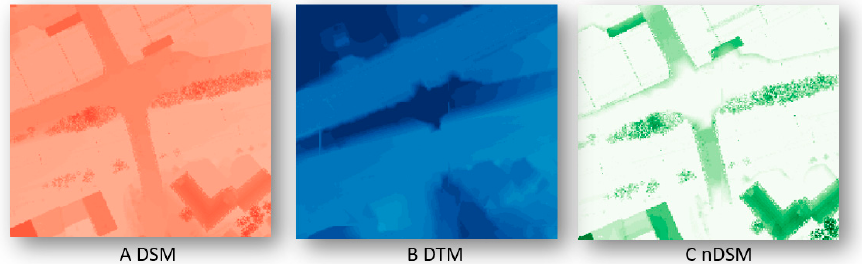
Figure 3. Examples of DSM ( A ), DTM ( B ), and nDSM ( C ) from Riegl VG-1560i LiDAR scanner ac- quired by the Terratec AS Company in August 2019 over Baerum municipality, Oslo,